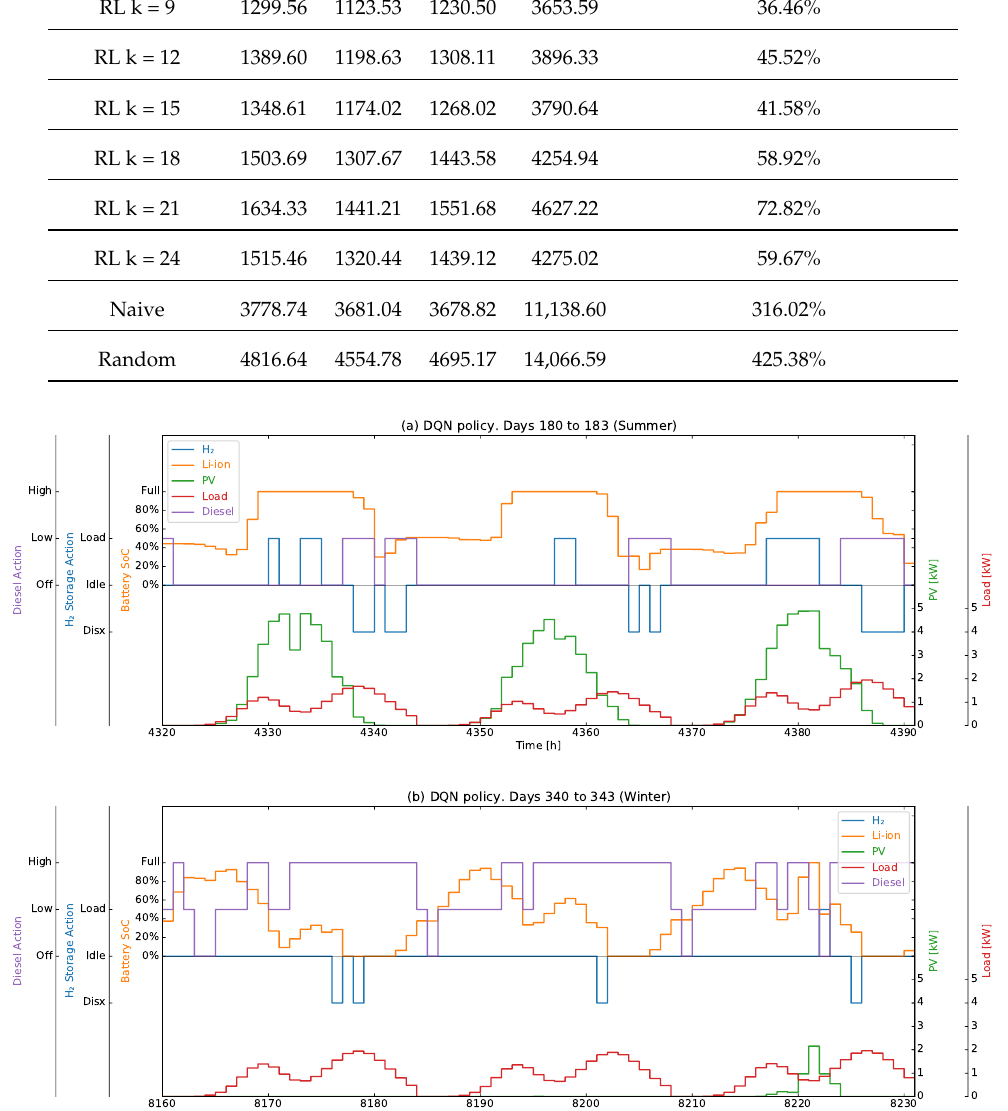
Figure 4. DQN operation of the microgrid, for summer ( a ) and winter ( b ). Hourly steps in a 3-day